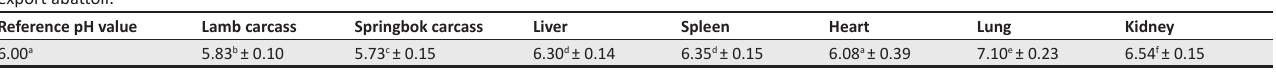
) post-slaughter for springbok edible offal organs and carcasses ( N = 55) supplied to the 16-24h